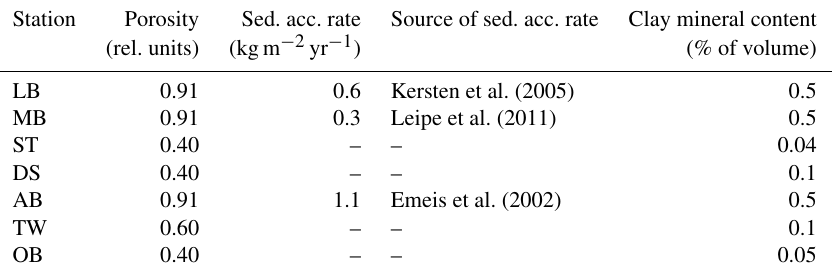
Table 7. Porosity and sediment accumulation rate data used as model input and clay volume content estimated by the model based on an initial